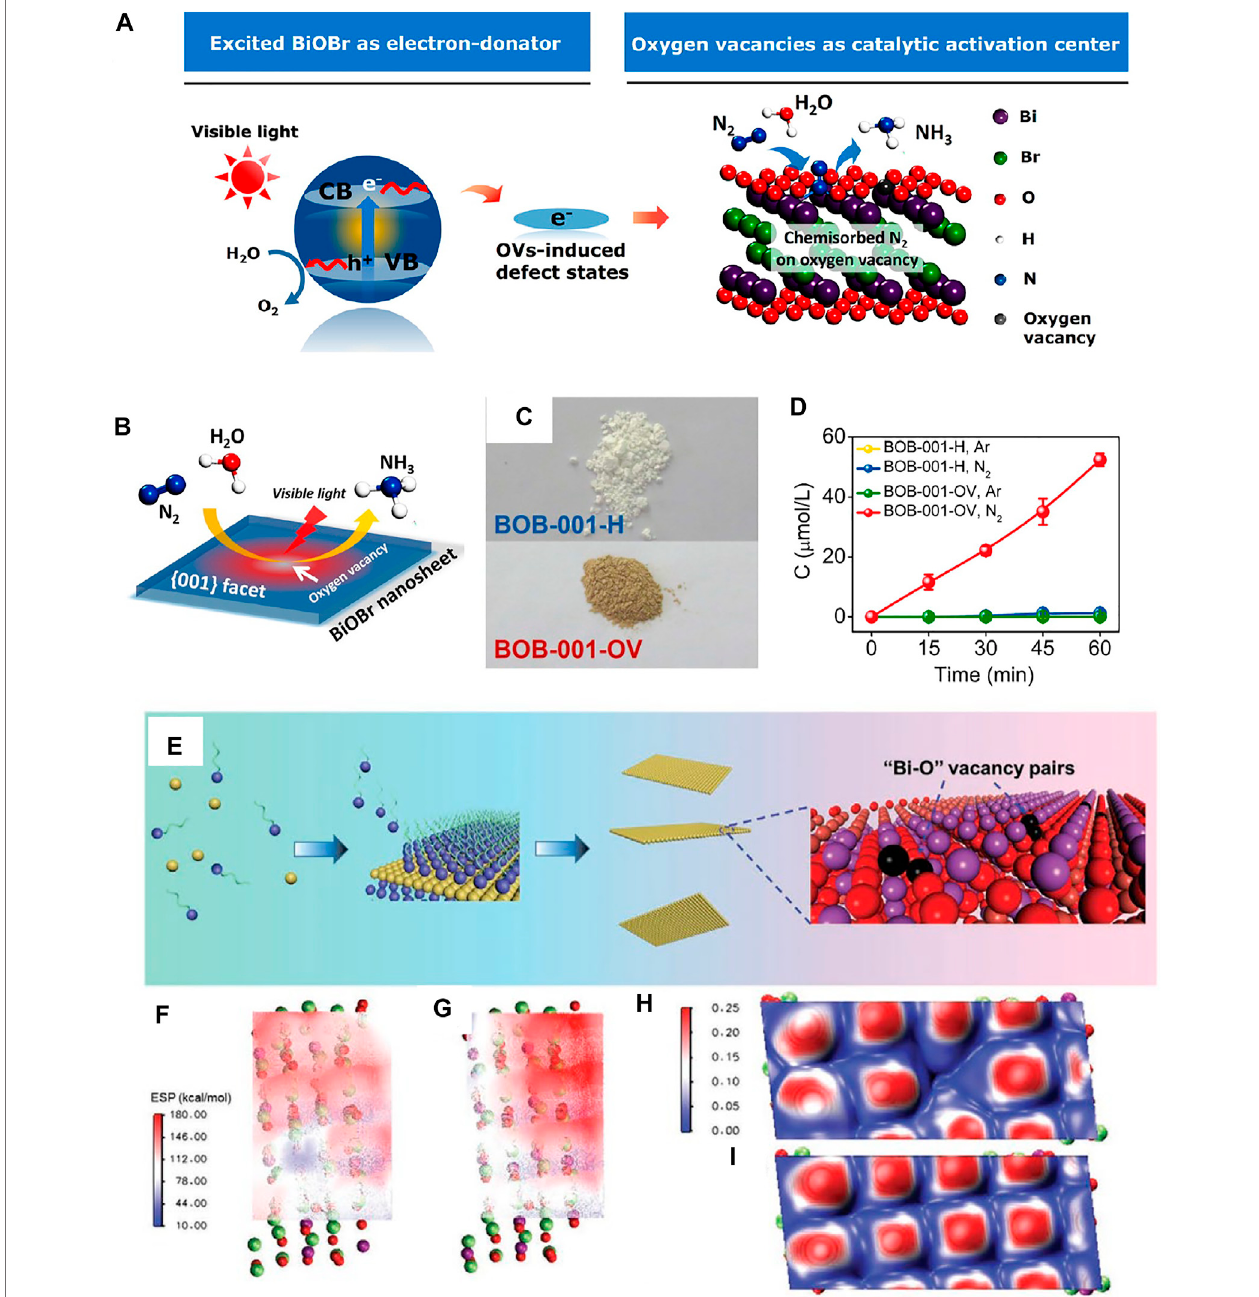
FIGURE 10 | (A) Schematic map of photocatalytic N 2 fi xation over BiOBr with OV. (B) Photocatalytic N 2 fi xation model with water as both the solvent and proton source. (C) Colors of BiOBr with or without OV. (D) Quantitative monitoring of NH 3 formed over different photocatalysts (Li et al., 2015d). (E) Illustration of the formation process of Bi 24 O 31 Br 10 with Bi-O vacancy pairs. Electrostatic potential of (F) Bi 24 O 31 Br 10 with Bi-O vacancy pairs and (G) perfect Bi 24 O 31 Br 10 . Electron localization function of (H)